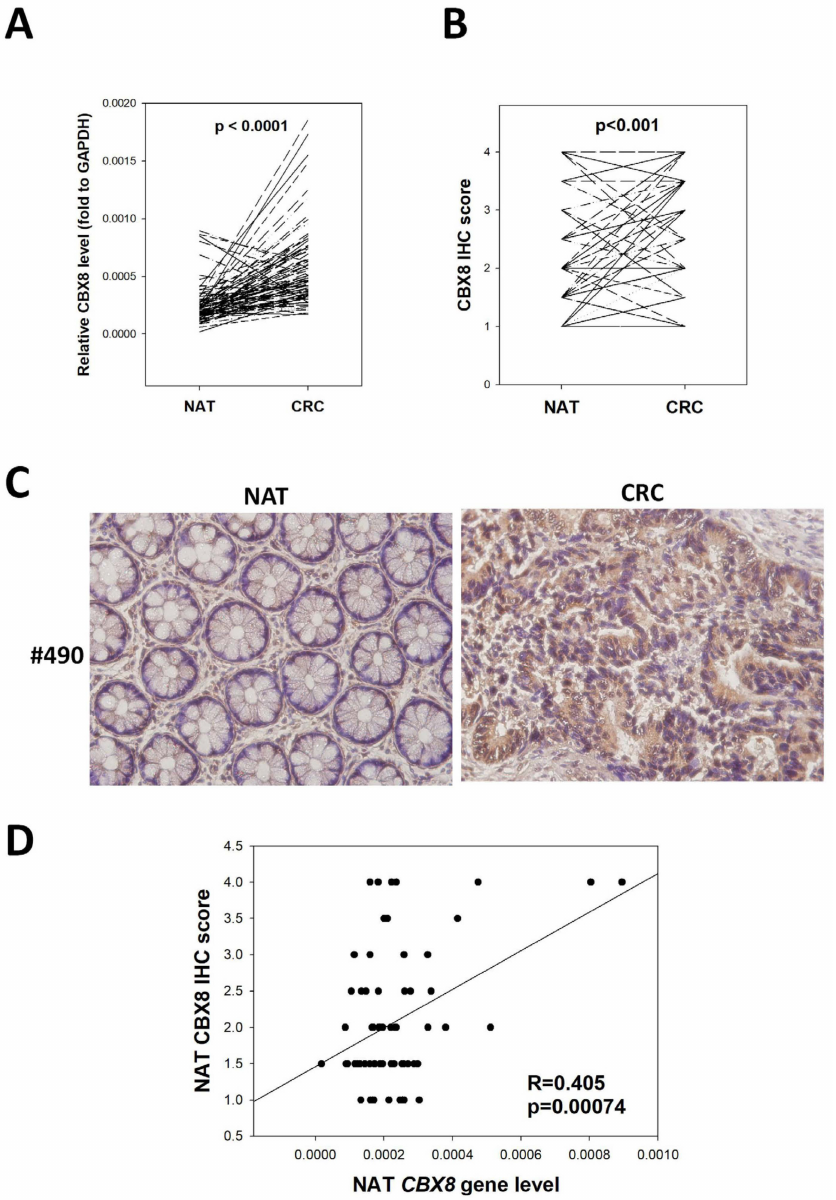
Figure 1. Clinical significance of CBX8 expression in CRC patients. ( A ) The CBX8 gene was signifi- cantly overexpressed in CRC when compared to paired NAT tissue ( n = 95). ( B ) The CBX8 protein level was significantly higher in CRC when compared to paired NAT tissue ( n = 66). ( C ) Representative IHC stainings of CBX8 in patient #490 showed higher CBX8 level in CRC compared to paired NAT (Magnification: 40 × ). ( D ) A significant correlation was observed between CBX8 gene and protein levels within the NAT tissue ( n =